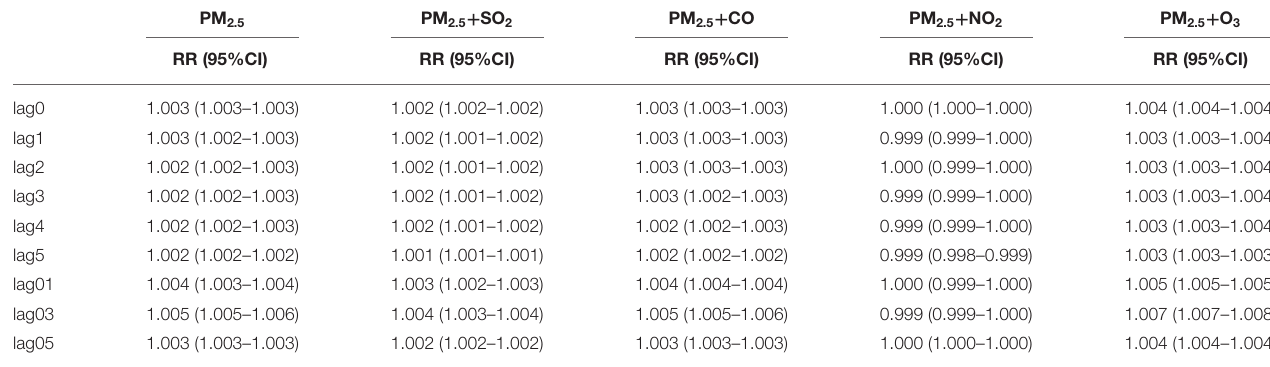
TABLE 2 | Relative risk (RR) for significant associations between air pollutions and daily respiratory outpatient visits due to lag